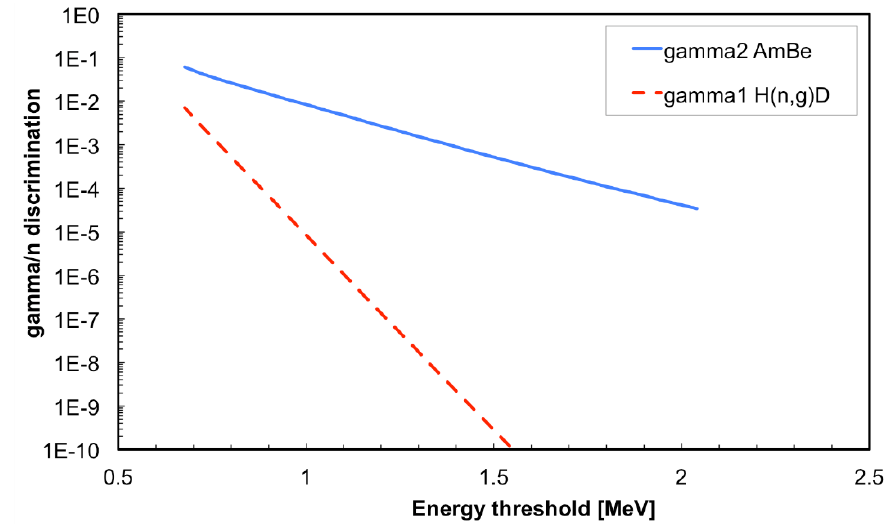
Figure 14. The γ/n ratio as a function of the chosen energy threshold, with respect to the gamma1 and gamma2 cases (see text).